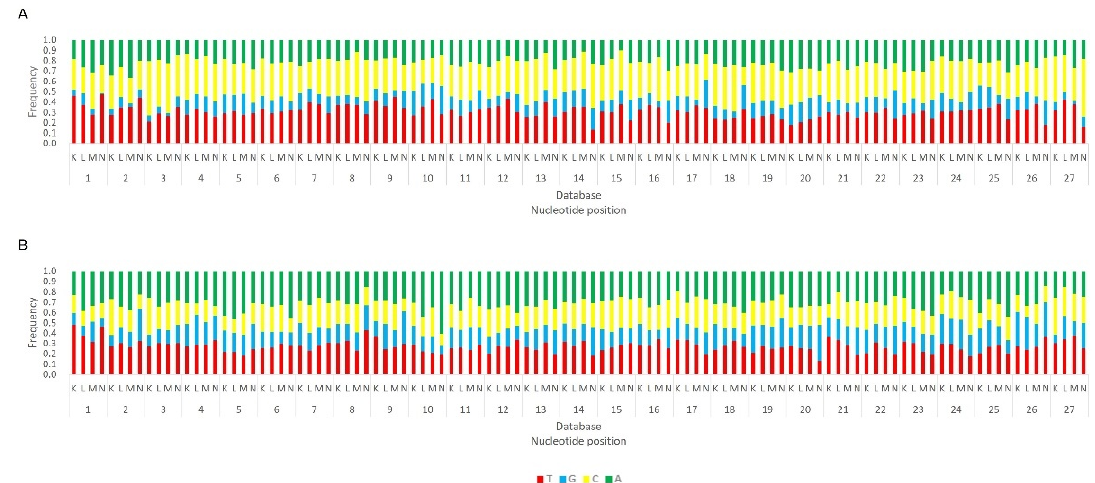
Figure 13. Relative nucleotide frequency of BmN4 Ago3-bound sense 27 nt-long sRNAs, mapped to the genome of B. mori Macula-like Latent Virus (MLV) ( A ) and S. frugiperda Rhabdovirus (RV) ( B ), databases F–I (Table S2). The Y -axis represents the relative nucleotide frequency. The X -axis represents the position in the read. T: thymine; G: guanine; C: cytosine; A: adenine. Since the sequenced reads correspond to cDNA, thymine corresponds to uracil in the original RNA molecule.